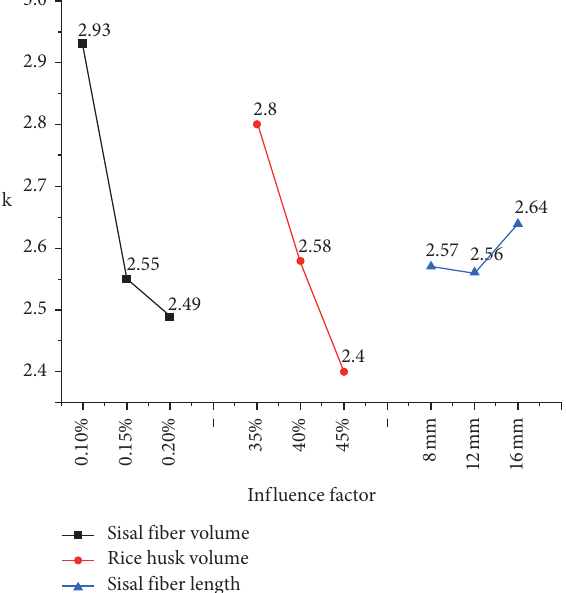
Figure 6: k value diagram of the flexural